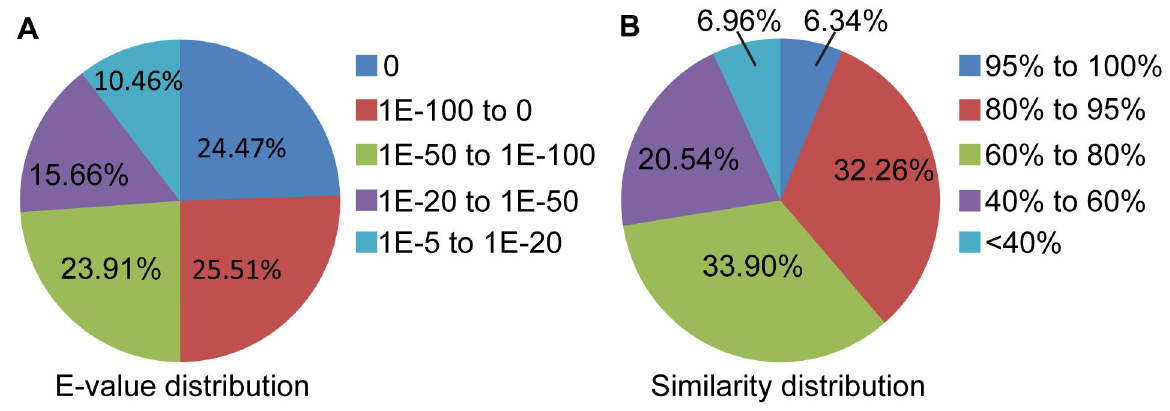
Figure 2. Characteristics of gene annotation of assembled transcripts against the reference dataset. (A) E-value distribution of BLASTX hits for transcript with a cut-off E-value of 1E-5. (B) Similarity distribution of BLASTX hits for transcript.